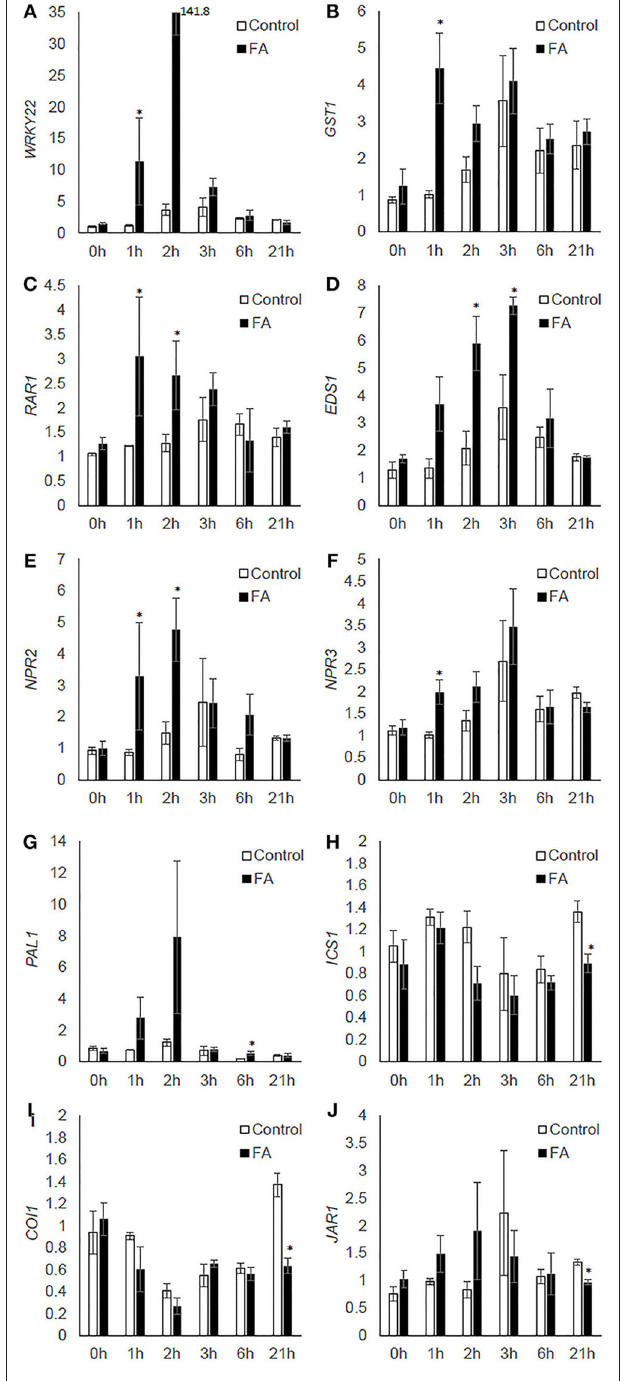
FIGURE 5 | The effect of formic acid on the transcriptional levels of citrus defense-associated genes (A–J) at 1, 2, 3, 6, and 21h after treatment. Leaf samples were collected at each time point from three formic acid-exposed C. macrophylla plants (FA) and three untreated controls (control). Leaves collected prior to treatments were used as 0h reference. The relative quantification of each gene was calculated by normalization with citrus endogenous gene GAPDH and referenced to one randomly selected 0h sample. An asterisk indicates significant difference between treatment and control at each time point (Kruskal-Wallis, α = 0.05). Bars are means ± SEM ( n =